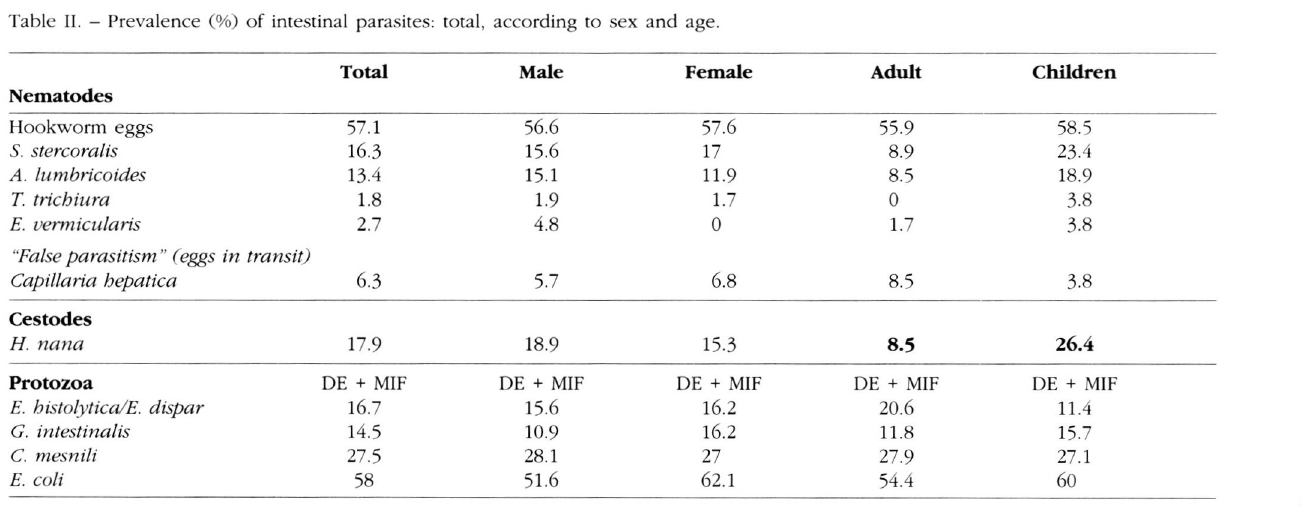
Nematodes Hookworm